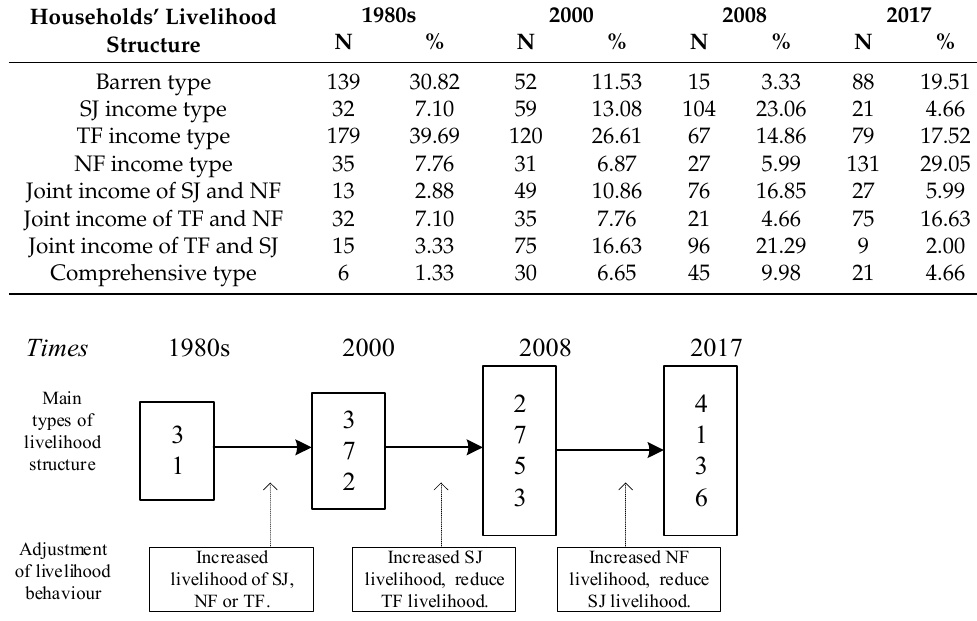
Table 2. Number and proportion of households with different livelihood structures in four periods. Households’ Livelihood Structure